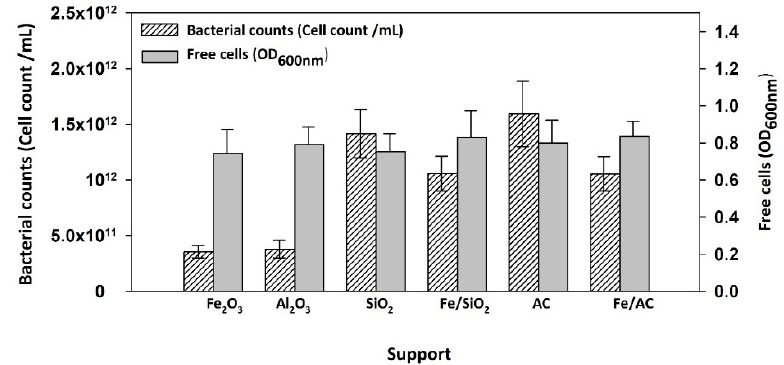
Figure 4. OD measurement for free cells and counts of attached cells on the support.